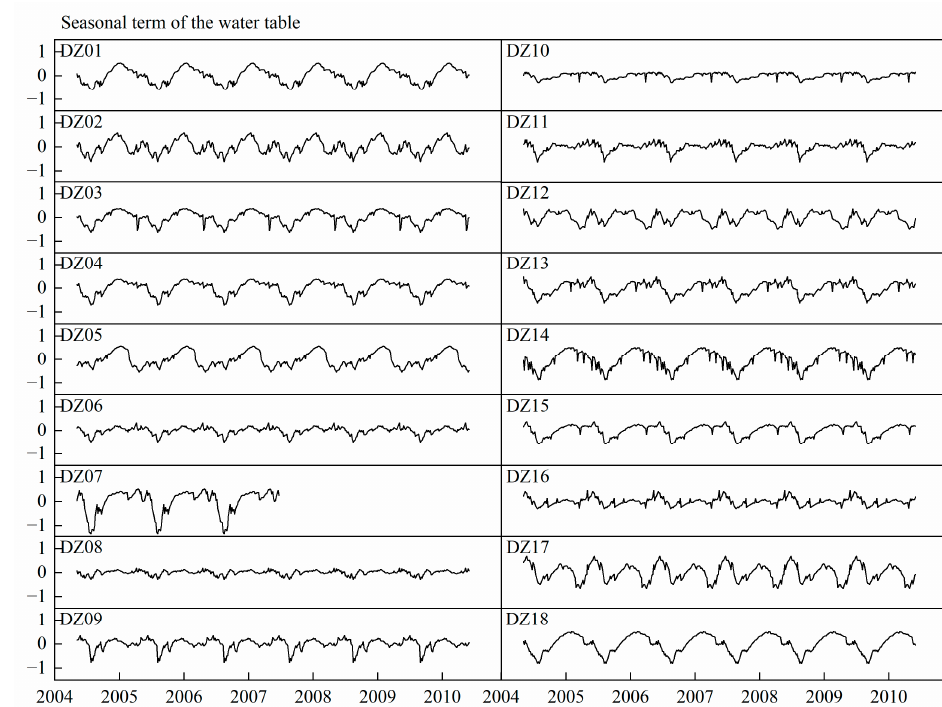
Figure A3. The seasonal term of GWL of each observational well varies with time.